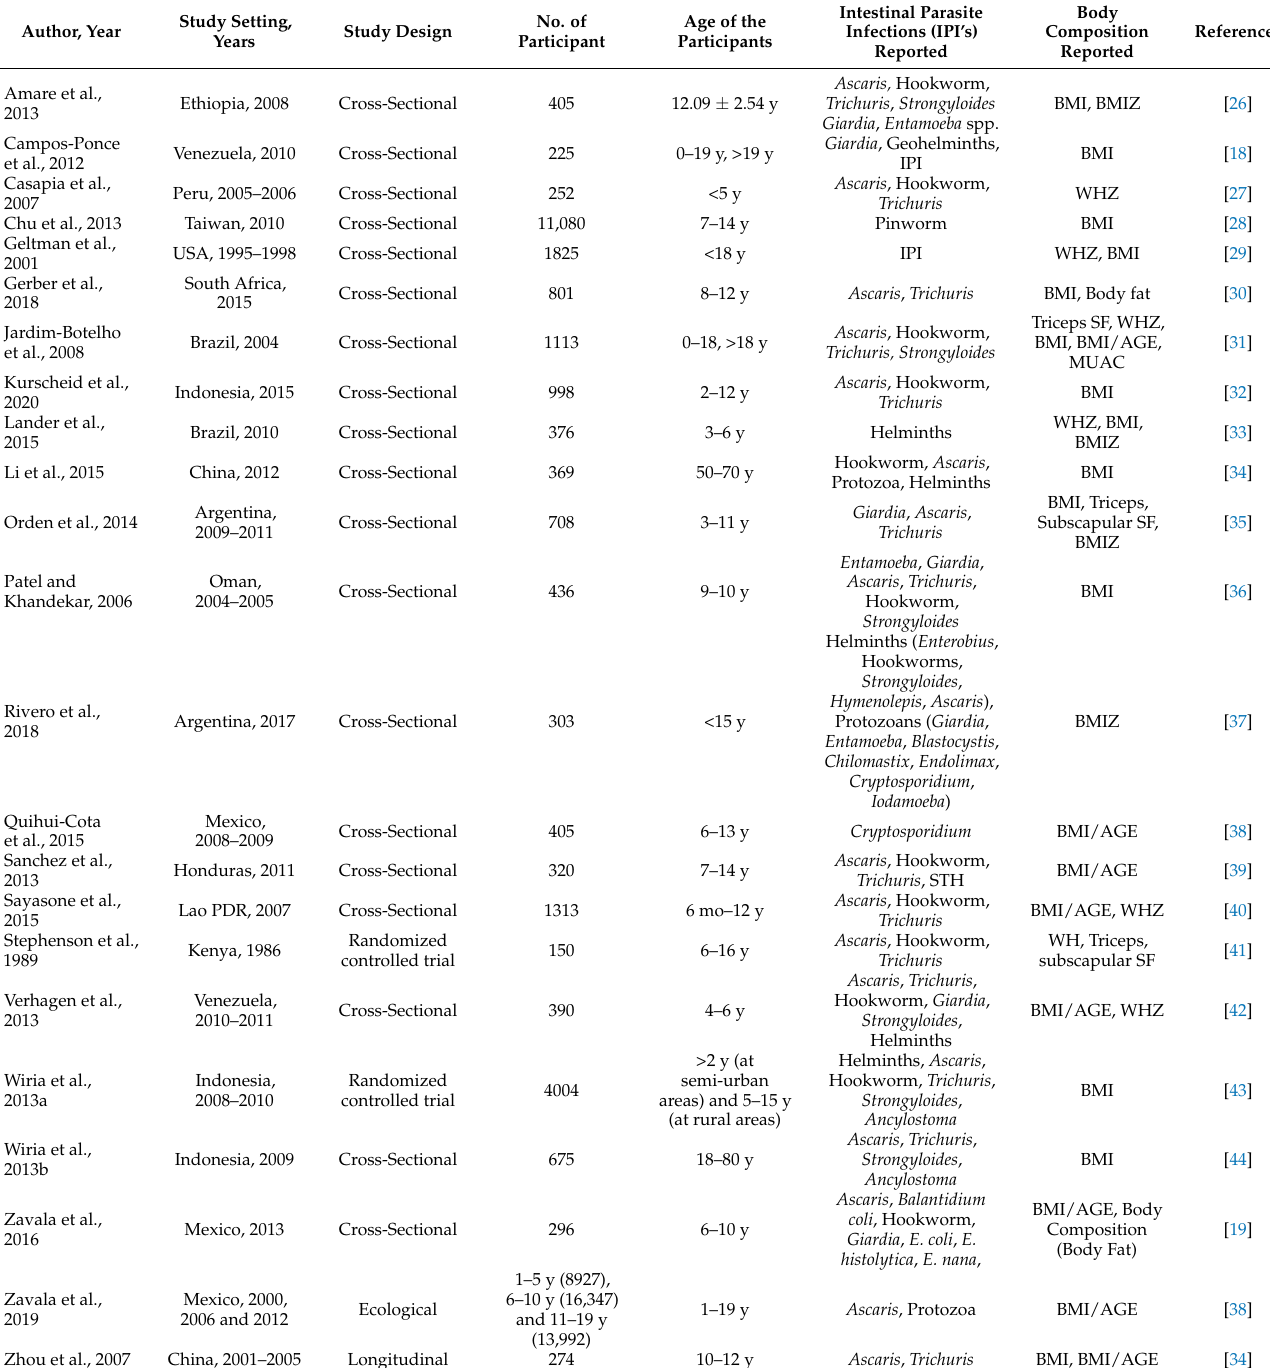
Table 2. Characteristics of the studies